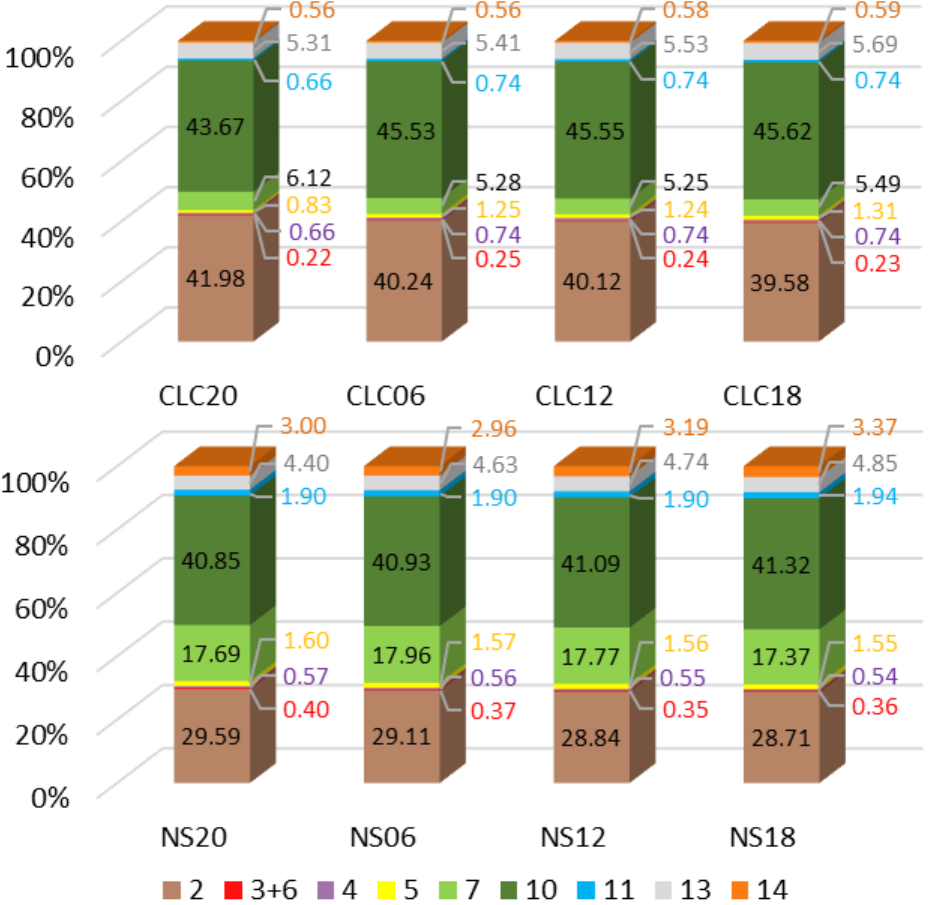
Figure 2. Development of relative land use (LU) values for the Slovak Republic according to recorded national statistics (NS) data and comparison with CLC3 data in 2000, 2006, 2012, and 2018. LU codes according to NS: 2 arable land, 3 hop fields, 4 vineyards, 5 gardens, 6 orchards, 7 permanent grassland, 10 forest land, 11 water areas, 13 built-up areas and courtyards, and 14 other